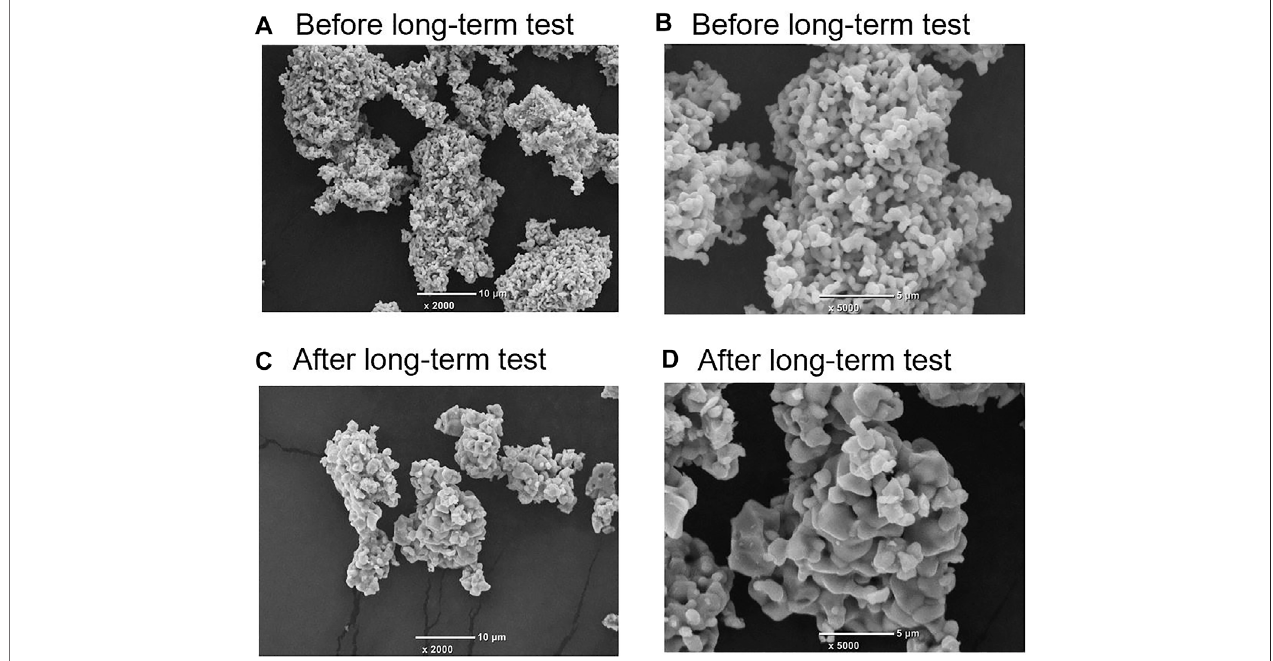
FIGURE8| Secondaryelectronimage(SEI)micrographoftheMg-substituted LSM.Theinitialsample(beforetesting)magni fi cationof (A) 2,000and (B) 5,000;the sample obtained after the long-term tests magni fi cation of (C) 2,000 and (D) 5,000.